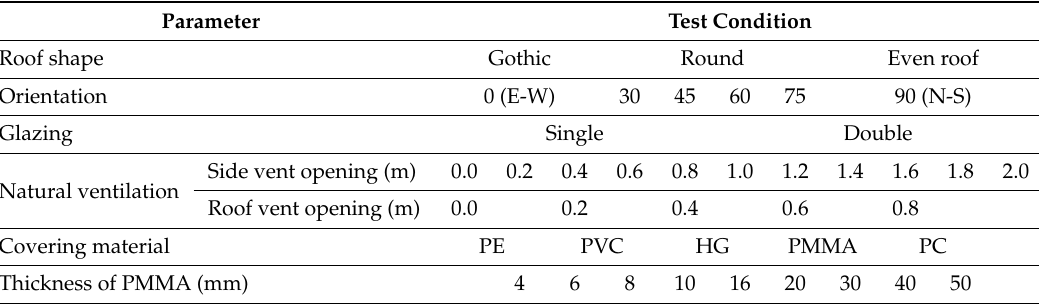
Table 2. Details of studied parameters.